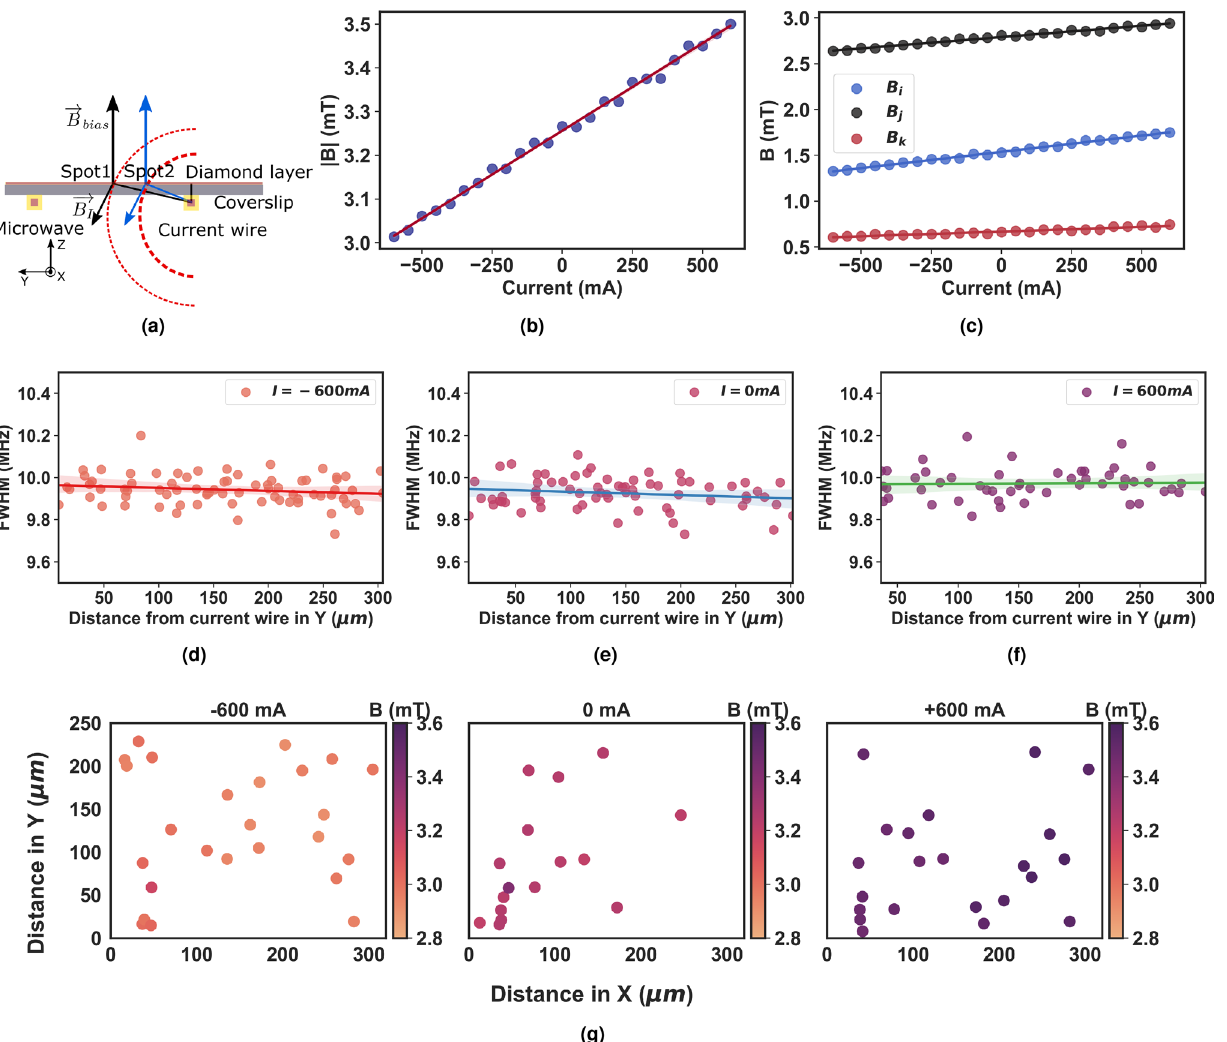
Figure 4. ( a ) Scheme of the arrangement of thin diamond layer (red), coverslip (grey), microwave and current wire (orange) with magnetic field lines (dashed magenta). B I and B bias denote the direction of the magnetic field vector for bias and current wire, respectively. ( b ) The three individual field components measured from a single diamond spot. ( c ) The total magnetic field value is plotted against different current intensities for a single diamond spot. ( d – f ) FWHM extracted from the Lorentzian fit for arbitrarily oriented diamond spots for current values -600 mA, 0 mA and 600 mA respectively. ( g ) Map of magnetic field strength for current set at −600 mA, 0 and 600 mA with the field strength indicated in the colorbar. The scatter points indicate the XY position of the randomly oriented micro-diamond crystal in the field-of-view. The current wire is situated to the right of the field